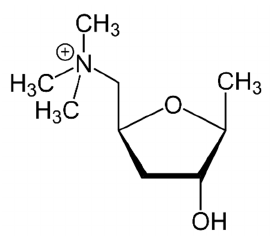
Figure 5. Structure of muscarine.